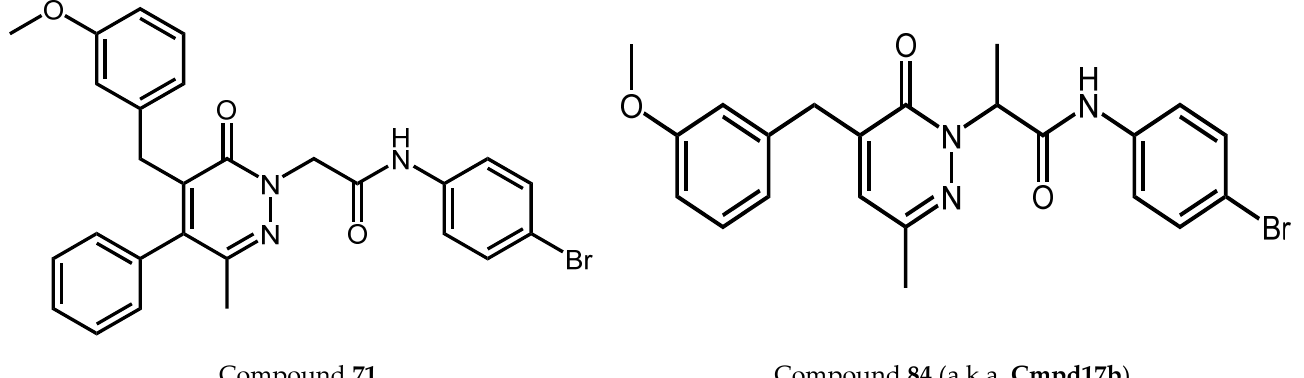
Figure 1. Structures of pyridazinones 71 [N-(4-bromophenyl)-2-[5-(3-methoxybenzyl)-3-methyl-6-oxo-4-phenylpyridazin-1(6 H )-yl]-acetamide] and 84 [N-(4-bromophenyl)-2-[5-(3-methoxybenzyl)-3-methyl-6-oxopyridazin-1(6H)-yl]-propanamide].